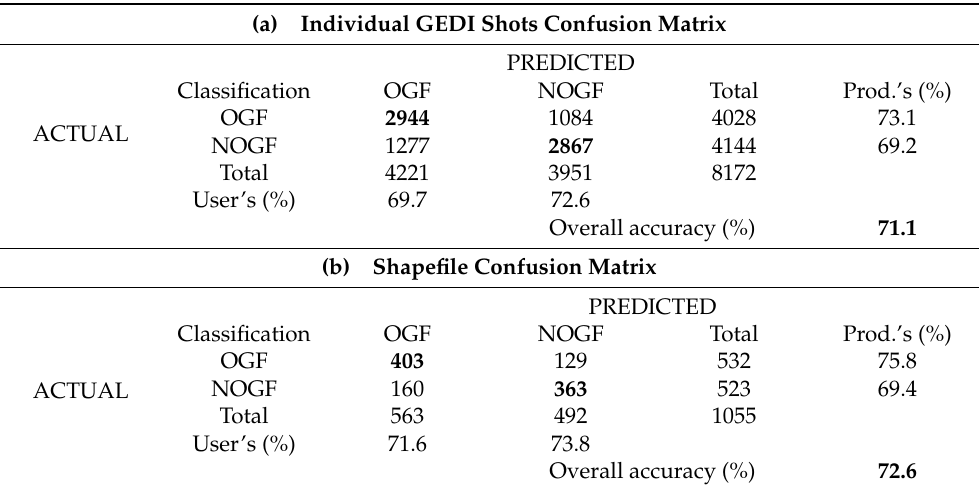
Table 4. Confusion matrix for Random Forest classification of old-growth forest (OGF) and non-OGF (NOGF) for (a) individual GEDI shots and (b) shapefiles. The bold text denotes correct classifications and the overall accuracy. User’s and Prod.’s indicates user’s and producer’s accuracies